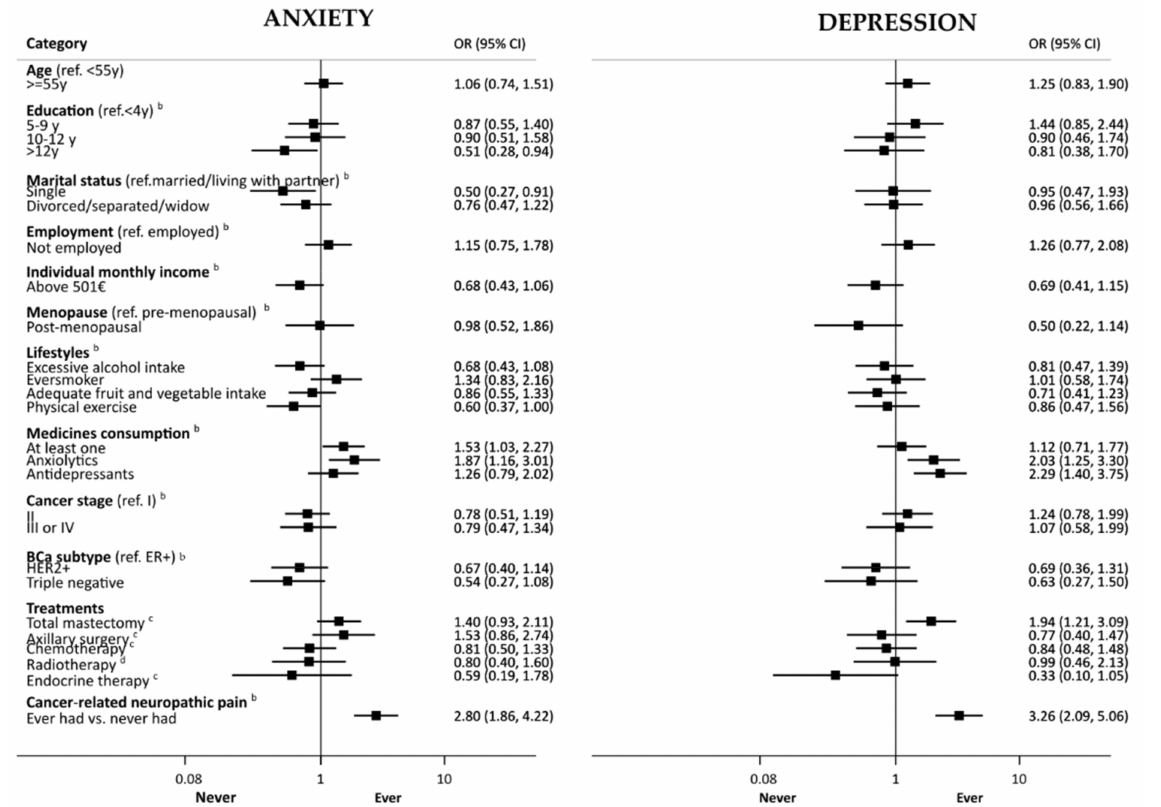
Figure 2. Association of baseline factors with having had clinically significant anxiety/depression symptoms (anxiety/depression sub score of the Hospital Anxiety and Depression Scale equal or higher than 11) at any evaluation during the five-year follow-up (prevalent cases). BCa, breast cancer; LND, lymph node dissection. Black boxes and horizontal lines represent OR and corresponding 95% CI, respectively, according to the log scale in the horizontal axis. a —adjusted for age; b —adjusted for age and education; c —adjusted for age, education, cancer stage and subtype; d —adjusted for age, education, cancer stage and subtype, breast